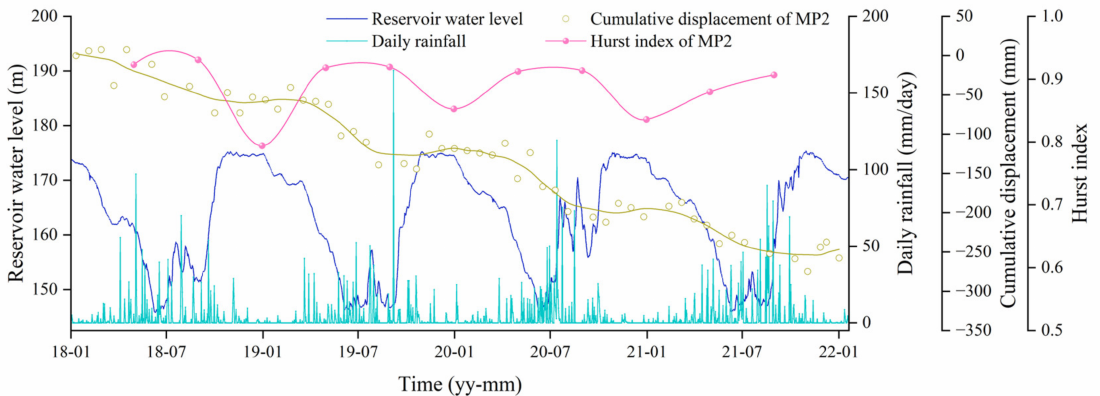
Figure 13. Relationships between cumulative displacement, Hurst index, rainfall, and reservoir water